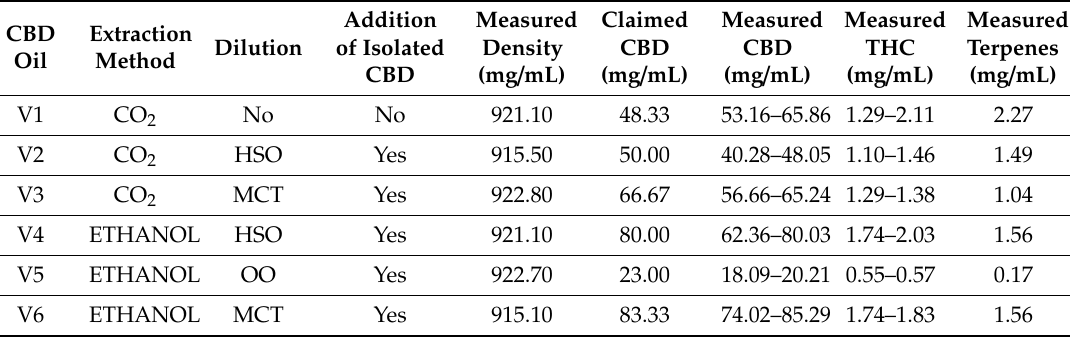
Table 1. Full-spectrum CBD